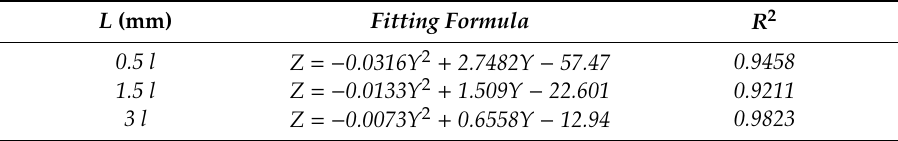
Table 3. Fitting formula of the annular gap flow velocity of the rear pipe vehicle. L (mm)